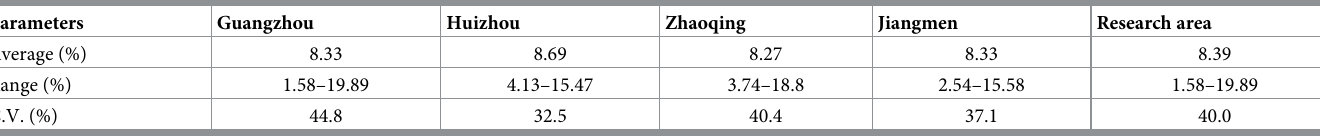
Table 2. Phosphorus activation coefficient in soil from different sampling sites (n = 190). Parameters